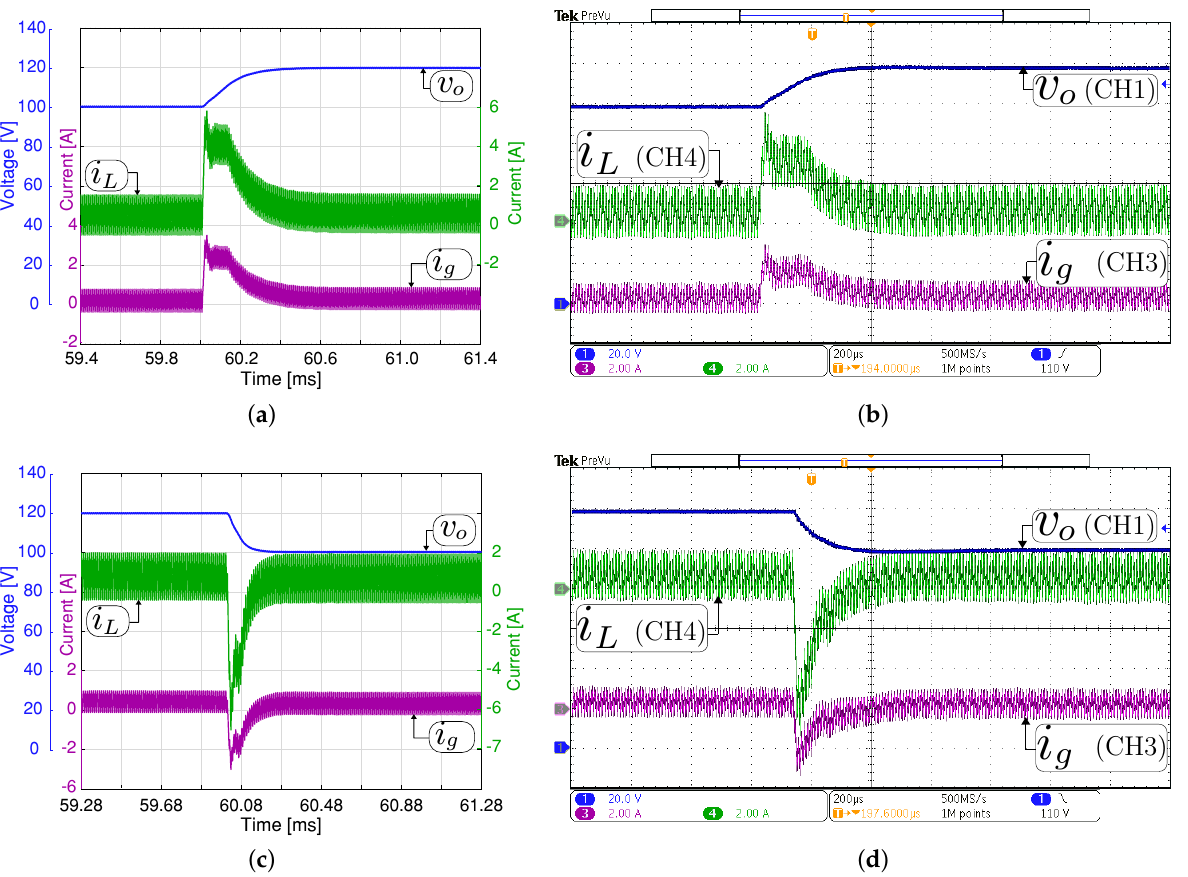
Figure 11. Large signal transient response with a constant resistive load R o = 200 Ω in buck mode ( V g = 200 V). Simulated ( a , c ) and experimental ( b , d ). Transient response when the output voltage reference changes from 100 to 120 V ( a , b ), and from 120 to 100 V ( c , d ). CH1: v o (20 V/div), CH3: i g (2 A/div), CH4: i L (2 A/div), and time base of 200 µ